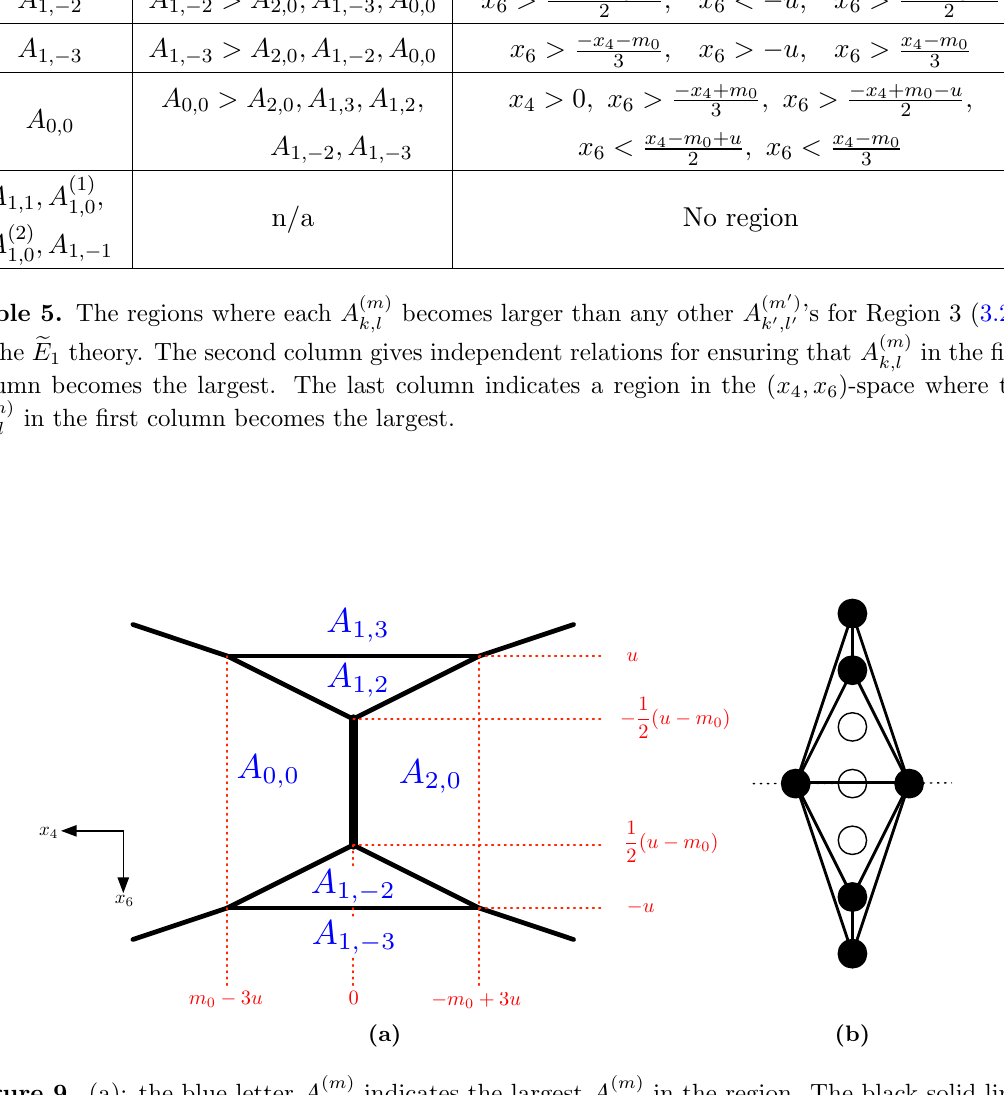
indicates the largest A ( m ) in the region. The black solid lines k;l k;l E 1 theory with a triangulation given e